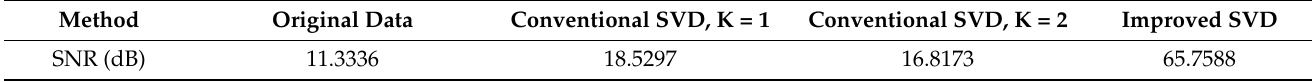
Table 4. SNR comparison of denoised results from different